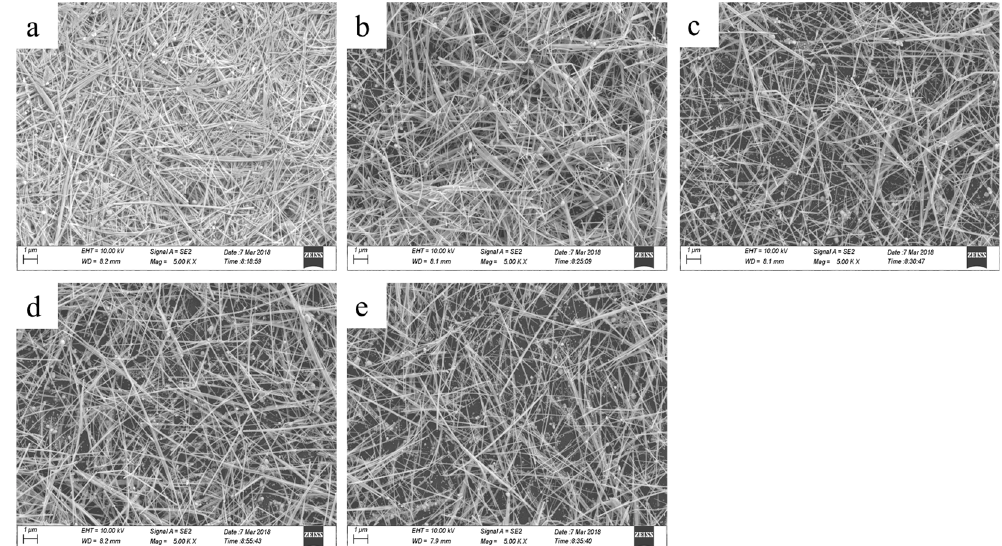
Figure 5. SEM images of the coatings of AgNWs with different lengths, ( a ) 7.64, ( b ) 8.66, ( c ) 10.93, ( d ) 11.21, ( e ) 13.49 μ m, respectively.